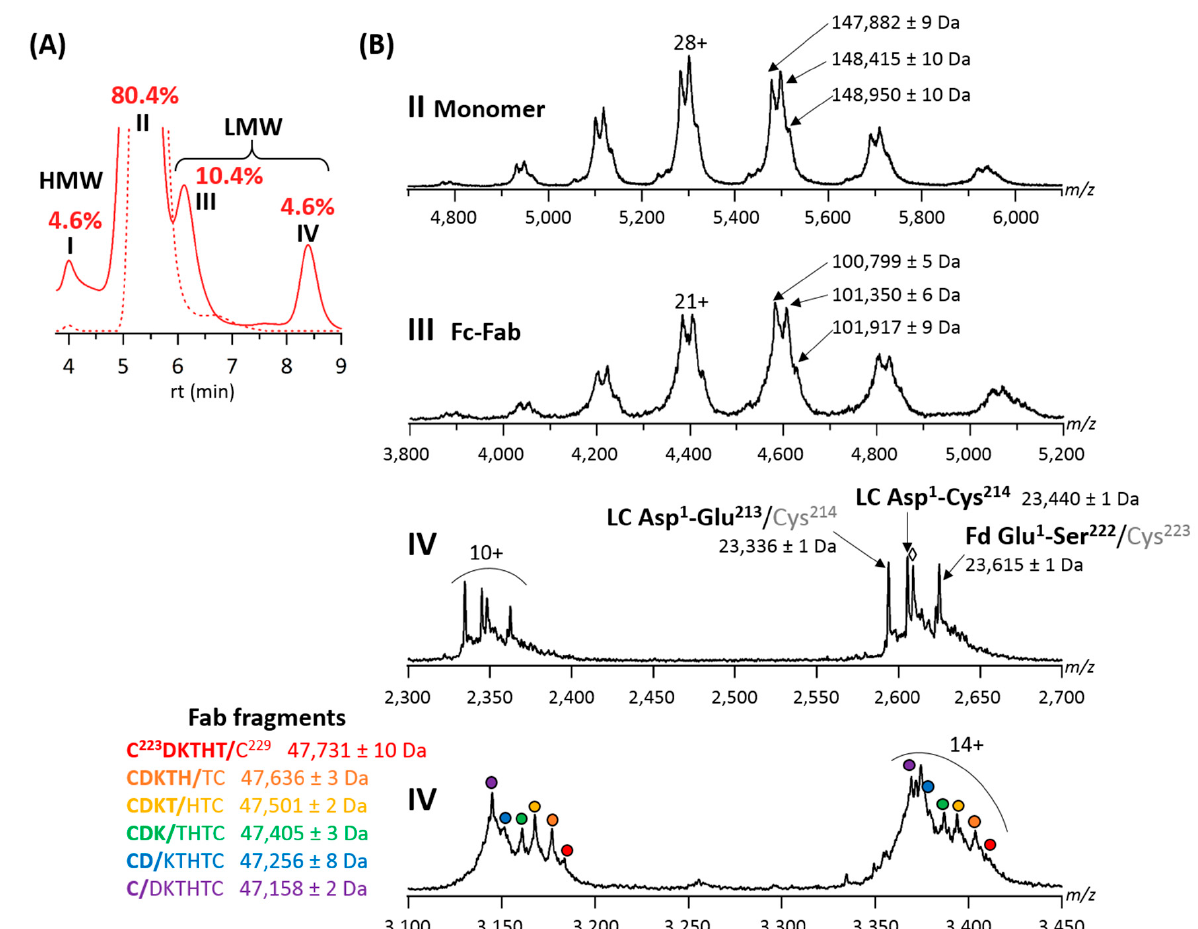
Figure 4. Online SEC-nMS analysis of thermally-stressed T-GlyCLICK-DM1. ( A ) Overlaid SEC chromatograms of stressed (solid line) and non-stressed (dotted line) samples. Relative amounts of HMWS and LMWS are given for the stressed sample; I = HMW dimers, II = main product, III = Fc-Fab fragments and IV = LC, Fd and Fab fragments. ( B ) SEC-nMS spectra of species generated upon thermal stress. ⬨ = sulfurized Cys 214 (+32 Da compared to LC Asp 1 -Cys 214 ). (cid:51)